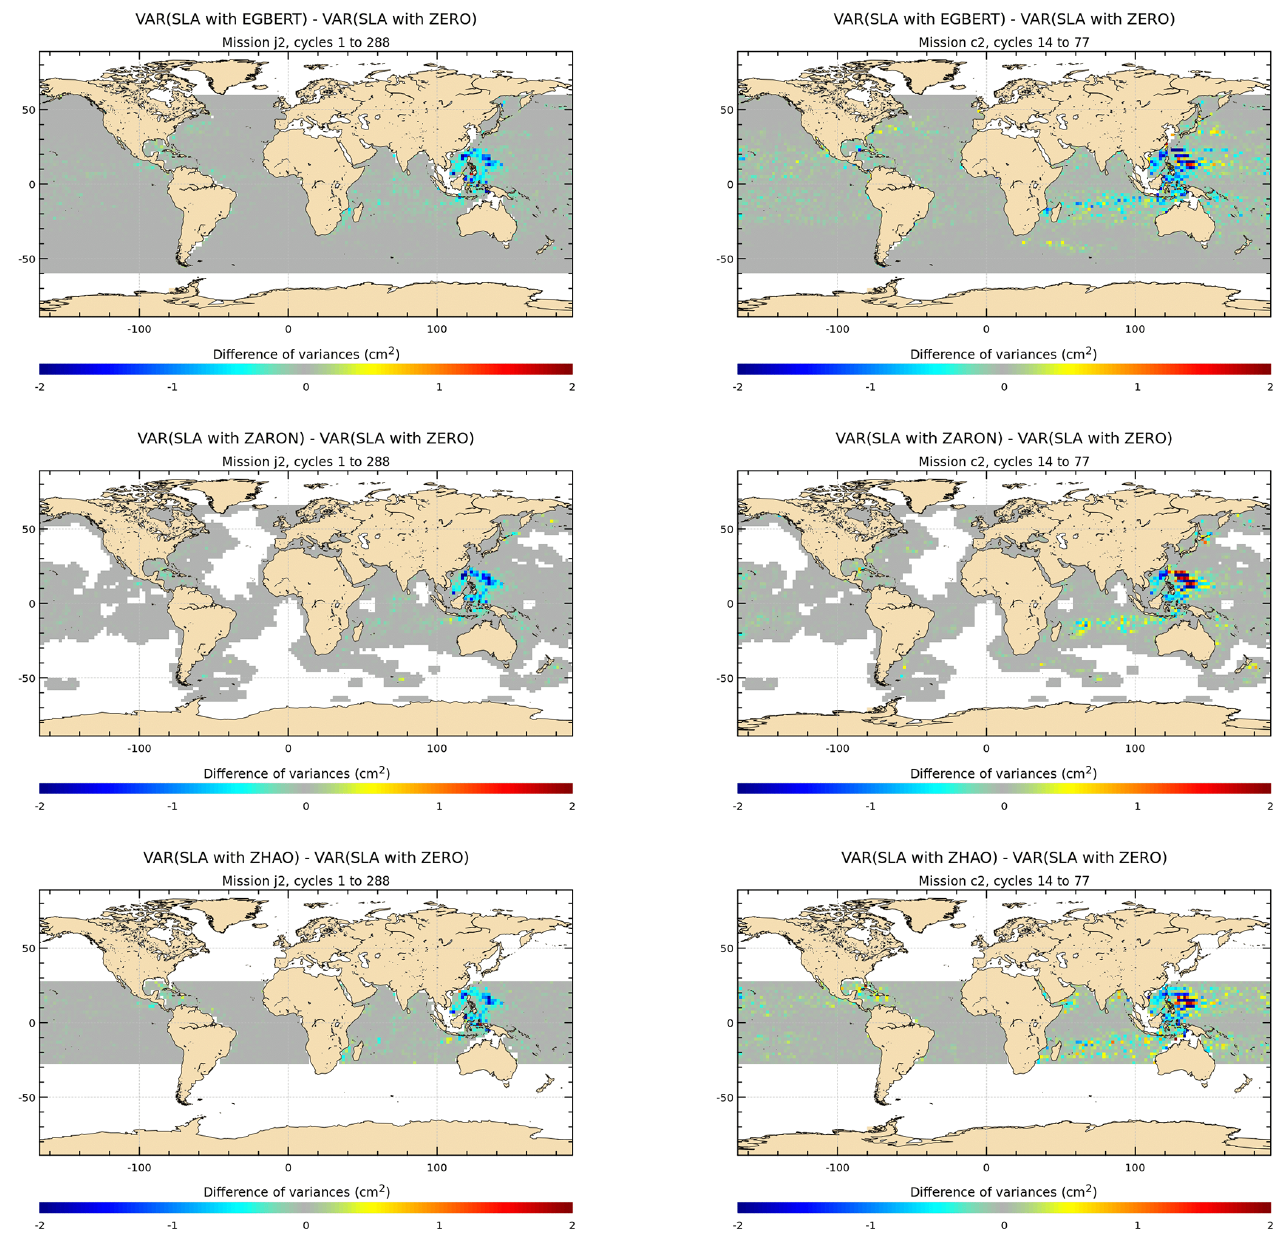
Figure B1. Maps of SLA variance differences using either the O 1 IT correction from each model or a reference ZERO correction in the SLA calculation for the J2 and C2 missions (cm 2 ). J2 cycles 1–288 have been used; C2 cycles 14–77 have been